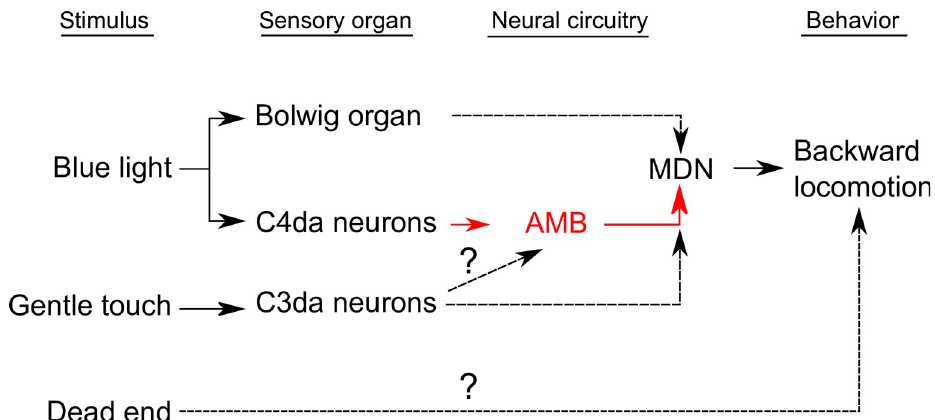
Fig 13. A circuit diagram of larval sensory systems and their potential downstream neurons that induce backward locomotion. Black solid lines indicate the functional connections shown in the previous studies[7,14,40]. Red solid lines indicate the functional connections shown in this study. Black dashed lines indicate the functional connections implied in this study.